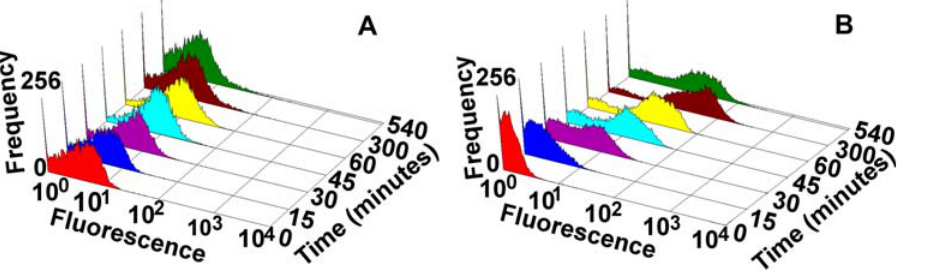
Figure 6. Frequency distribution of GFP fluorescence in experimental cell populations: (A) Basic (TG) and (B) Delay (C2TG) circuits. X- axis: Fluorescence in arbitrary units; Y-axis Time; Z-axis: Frequency.